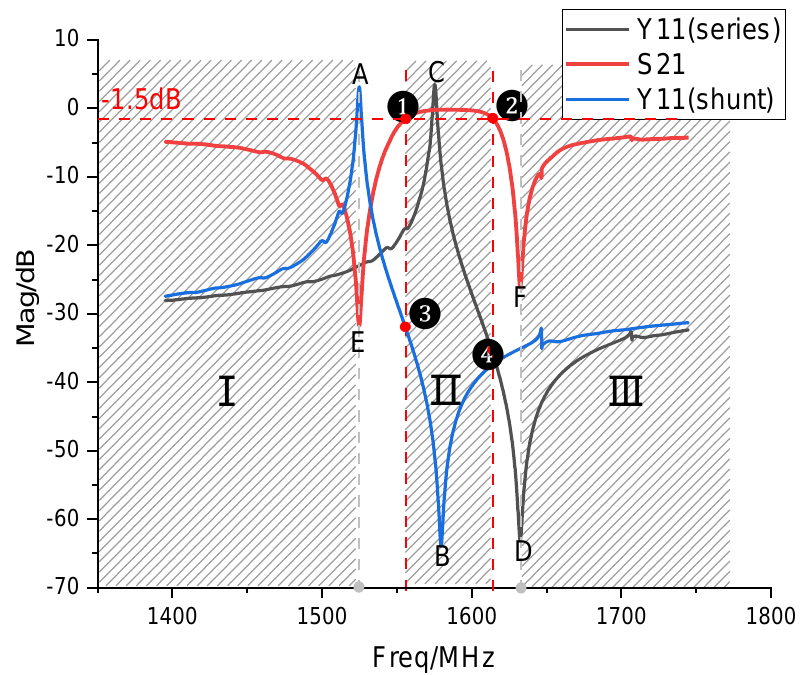
Figure 9. Ladder filter consisting of one series and one parallel resonator.